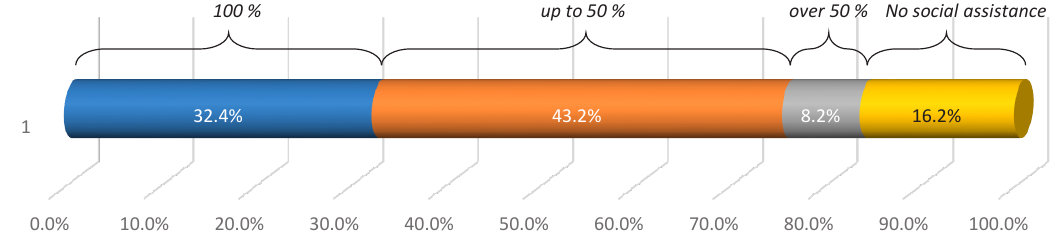
Figure 2. Share of social assistance in the total income of the IDPs, % of respondents